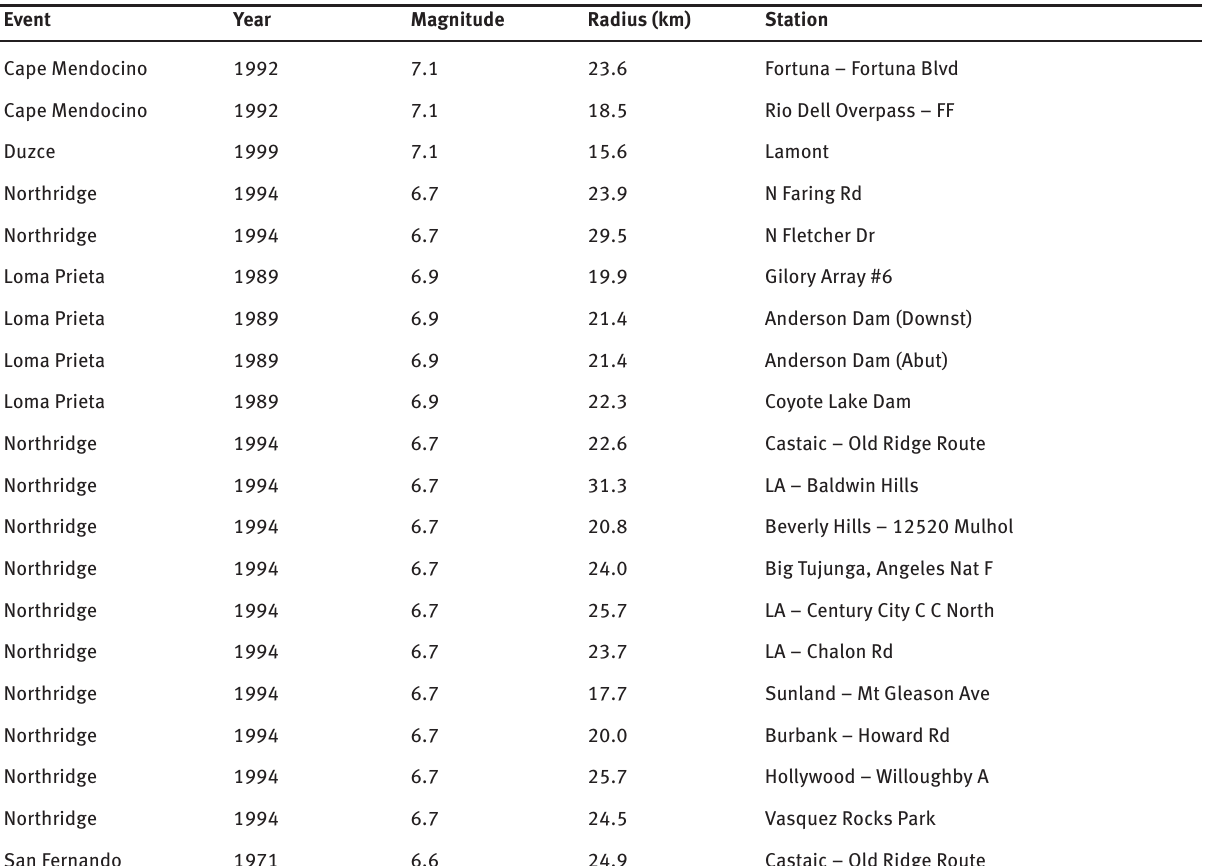
Table 3: Studied earthquake records and their characteristics.